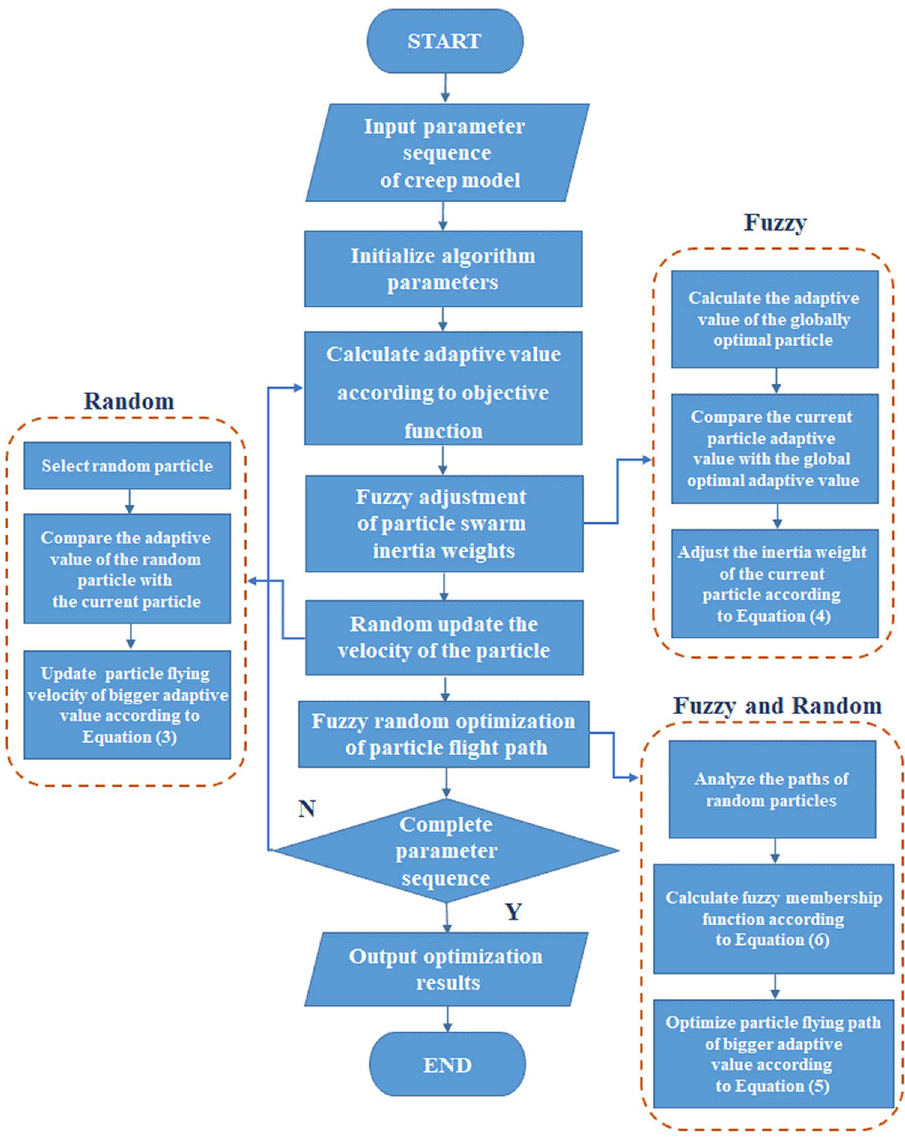
Figure 1. Flowchart of the fuzzy random particle swarm optimization algorithm.